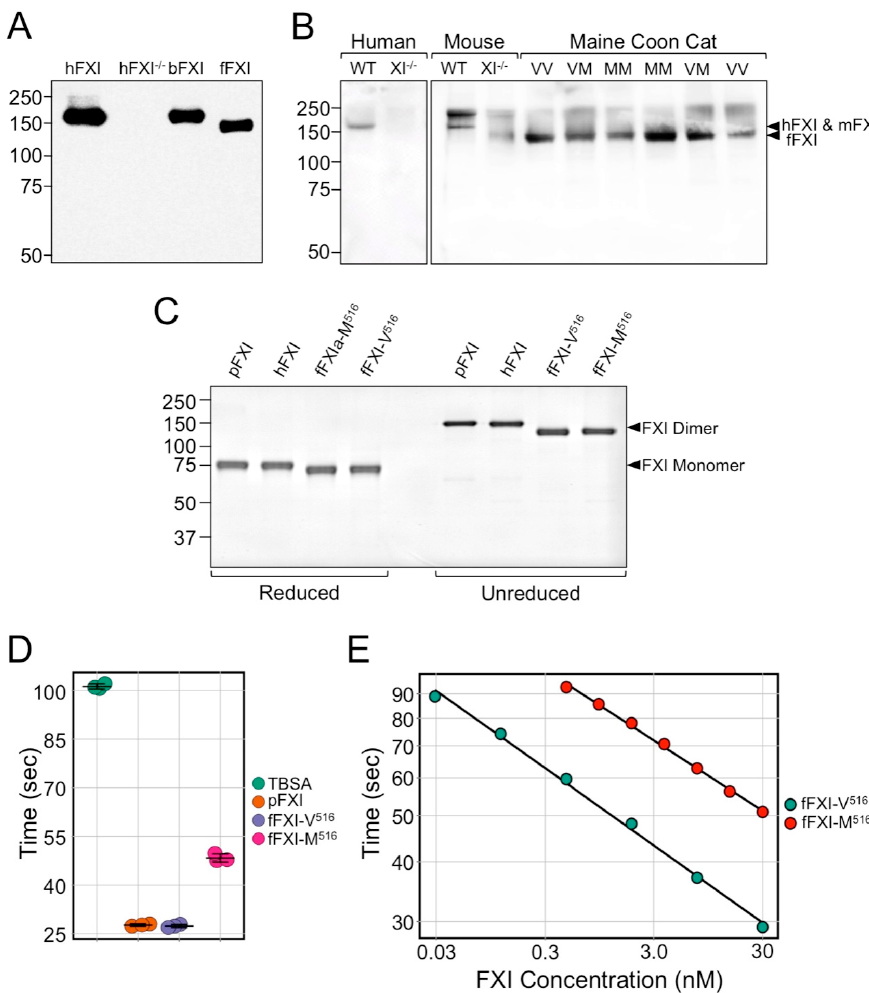
Figure 4. Plasma and Recombinant FXI. ( A ) Western blots of non-reducing 7.5% polyacrylamide gels of fXI immunoprecipitated from normal human plasma (hFXI), FXI-deficient human (hFXI − / − ), baboon plasma (bFXI) and domestic cat plasma (fFXI) with 14E11 linked to agarose beads. The primary detection antibody was biotinylated-14E11. ( B ) Western blots of non-reducing 7.5% polyacrylamide gels of wild-type (WT) or FXI-deficient (XI − / − ) human and mouse plasmas, and plasmas from MMCs homozygous for wild-type FXI (VV), homozygous for variant FXI (MM) or heterozygous for both forms of FXI (VM). The primary detection antibody was biotinylated-14E11. Positions of bands representing human (hFXI), mouse (mFXI) and feline (fFXI) are indicated on the right. ( C ) Coomassie blue stained 7.5% polyacrylamide gel run under reducing (left) or non-reducing (right) conditions of plasma-derived human FXI (pFXI); and recombinant wild-type human (hFXI), wild-type feline (fFXI-V516), and variant feline (fFXI-M516). Positions of the FXI monomer (reduced) and homodimer (unreduced) are indicated on the right. For panels A-C, positions of molecular mass standards in kDa are shown on the left. ( D ) aPTT clotting times for FXI-deficient human plasma supplemented with TBSA vehicle (TBSA), 30 nM plasma-derived human FXI (pFXI), 30 nM wild-type feline FXI (fFXI-V516), or 30 nM variant feline FXI (fFXI-M516). Reactions were run in triplicate. Horizontal bars indicate the means and one SD for each group. ( E ) Log-log plots of aPTT clotting times versus plasma FXI concentration for human FXI-deficient plasma supplemented with various concentrations of wild-type feline FXI (fFXI-V516) or variant feline FXI (fFXI-M516). The activity of the variant FXI as a percentage of wild-type FXI was determined, assuming the activity for 30 nM FXI-V516 was 100% of normal.